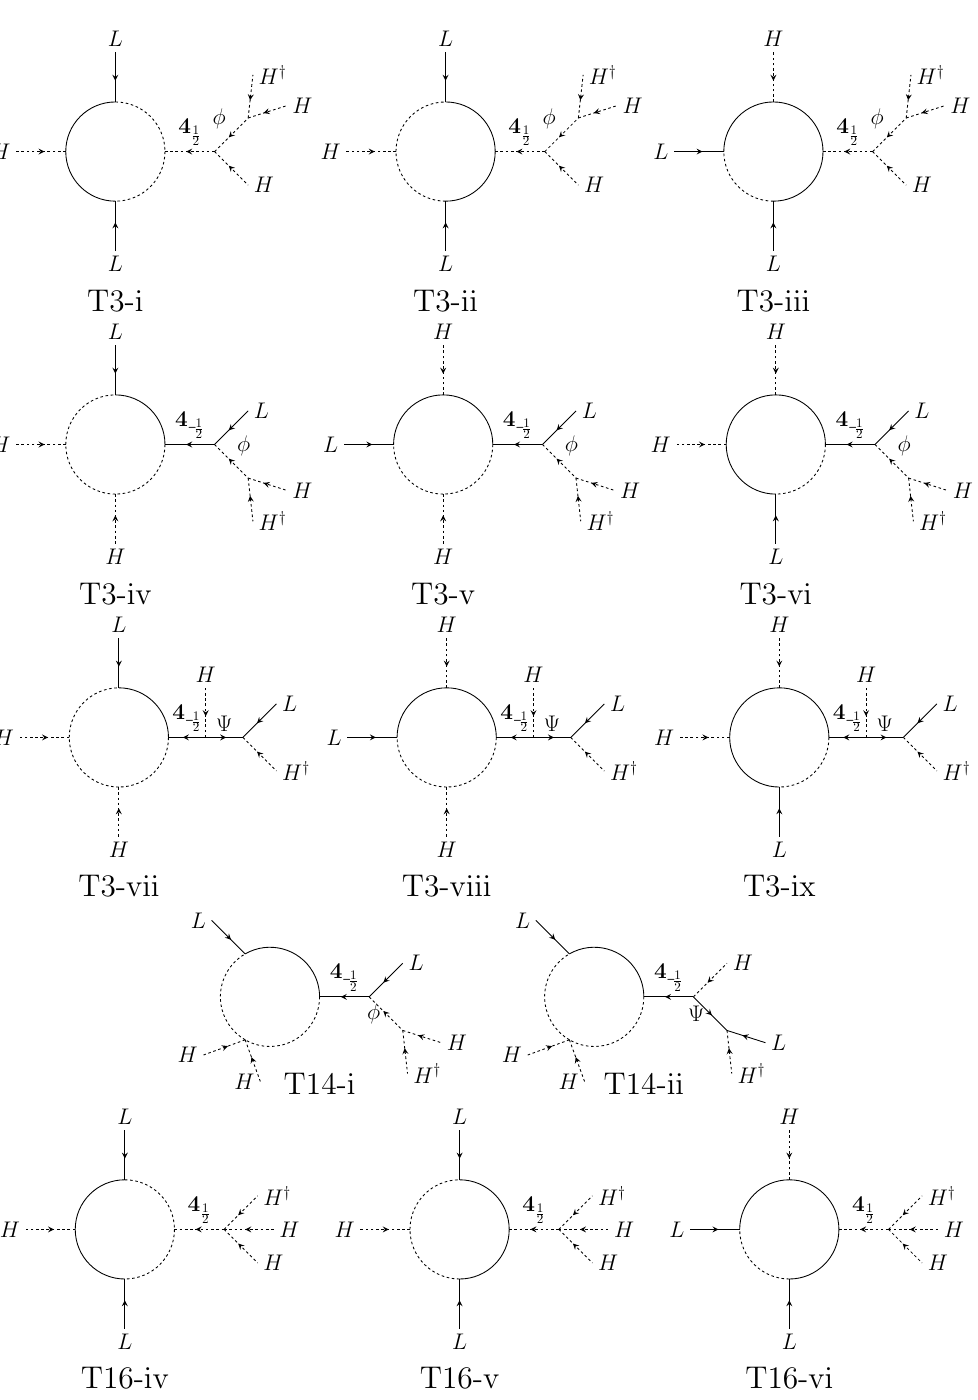
( 4 F ) and a Higgs ( L ). 1 = 2 (cid:0) 1 = 2